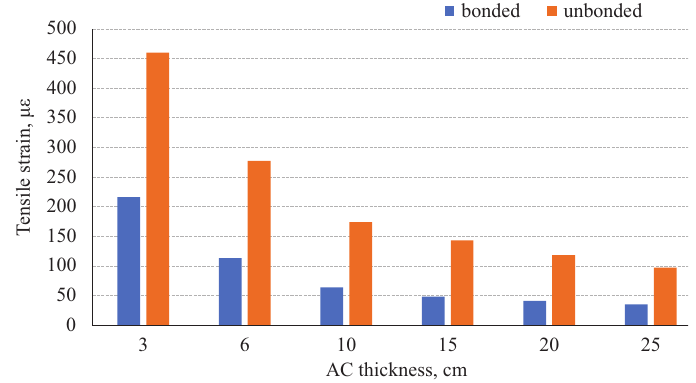
Figure 7. Effect of interfaces contact condition for different overlay